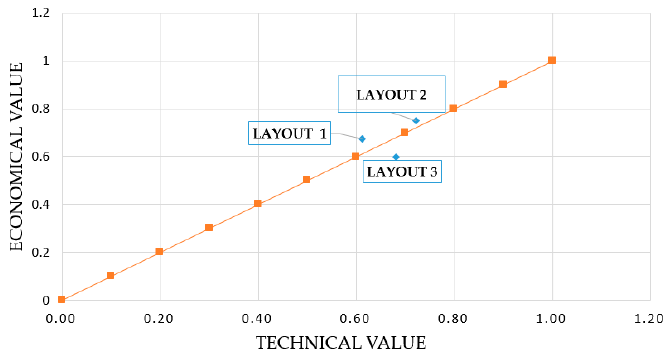
Figure 8. Assessment diagram in accordance with VDI-2221 [10].